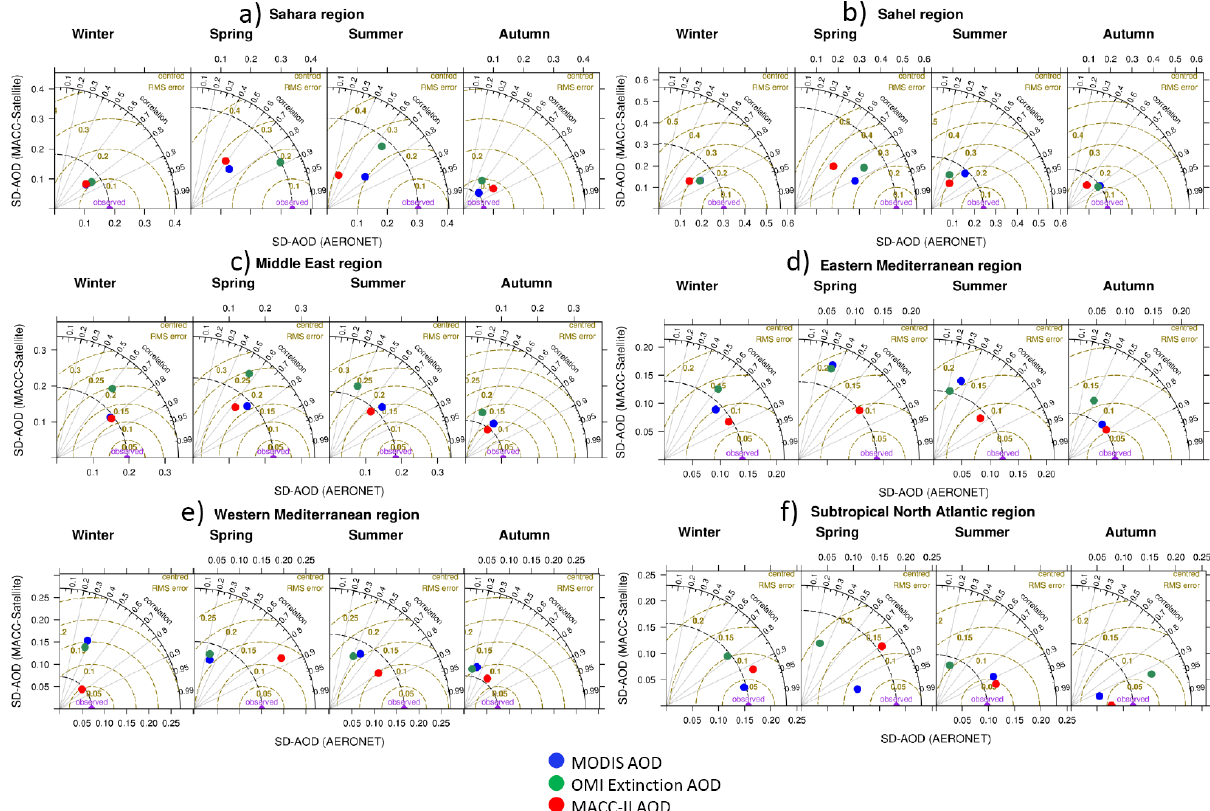
Figure 7. Taylor diagrams where seasonal AOD values from MACC-II, MODIS-Aqua and OMI are compared with AERONET AOD, used as reference, for Sahara (a) , Sahel (b) , Middle East (c) , Eastern Mediterranean (d) , Western Mediterranean (e) , and subtropical North At- lantic (f) . The similarity between MACC-II and satellite observations with AERONET observations is quantified in terms of their correlation, their centred root-mean-square error (CRMSE), and the amplitude of their variations (represented by their